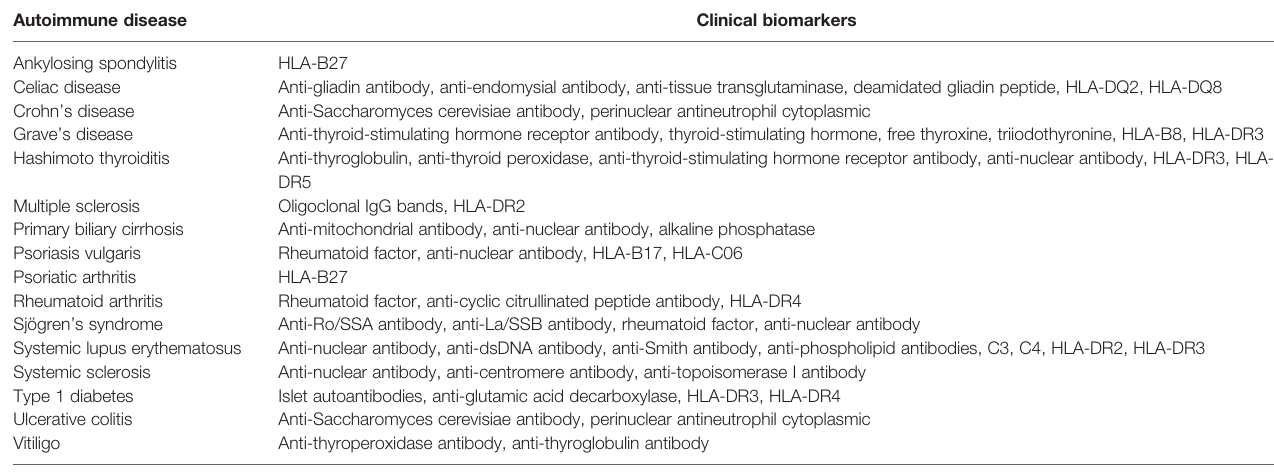
TABLE 2 | A list of clinical biomarkers for each autoimmune